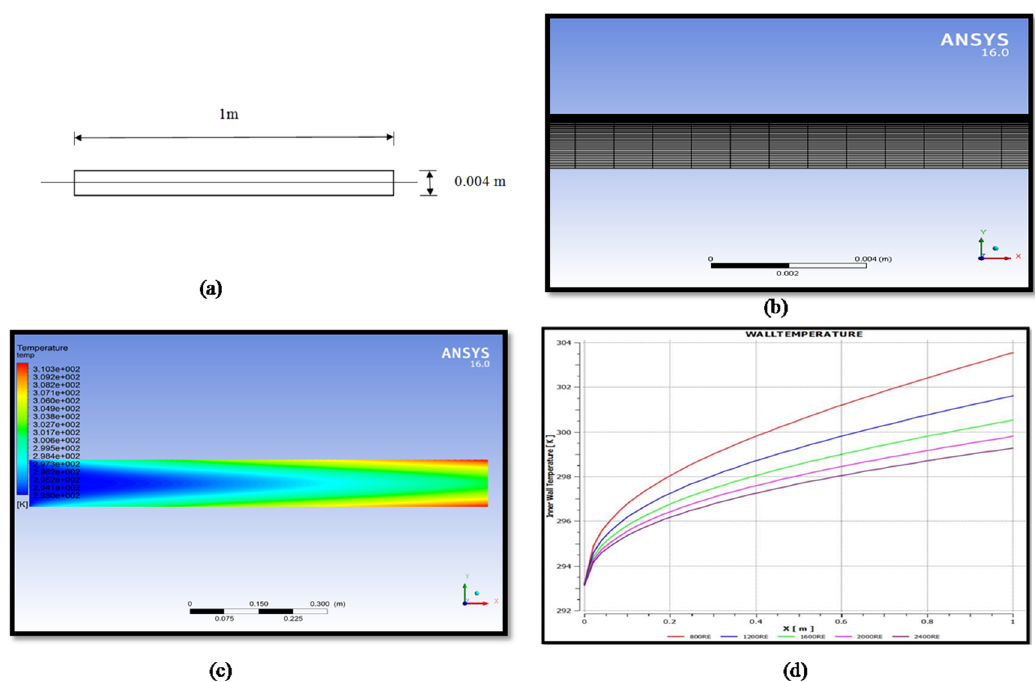
Figure 1. ( a ) Test Section Geometry ( b ) Sectional view of the Mesh Geometry ( c ) Temperature Con- tour for Re = 800 ( d ) Inner Wall Temperature along the length for various Reynolds numbers.